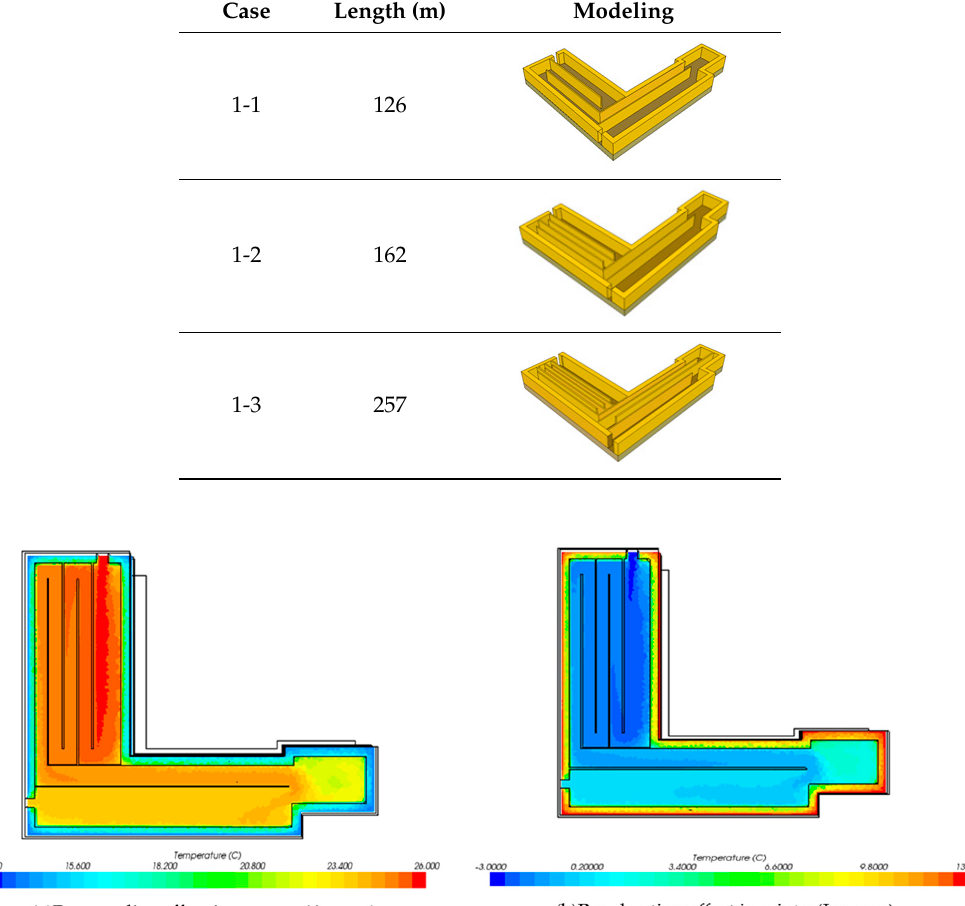
Figure 5. Example of pre-cooling and pre-heating effect (Case 1-2). ( a ) Pre-cooling effect in summer (August). ( b ) Pre-heating effect in winter (January).